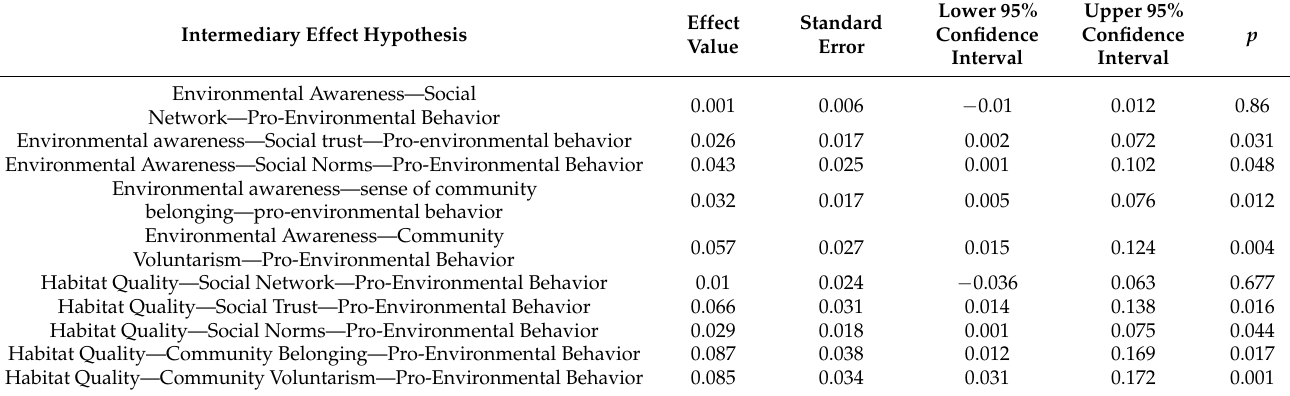
Table 7. Bootstrap method-mediated effect test